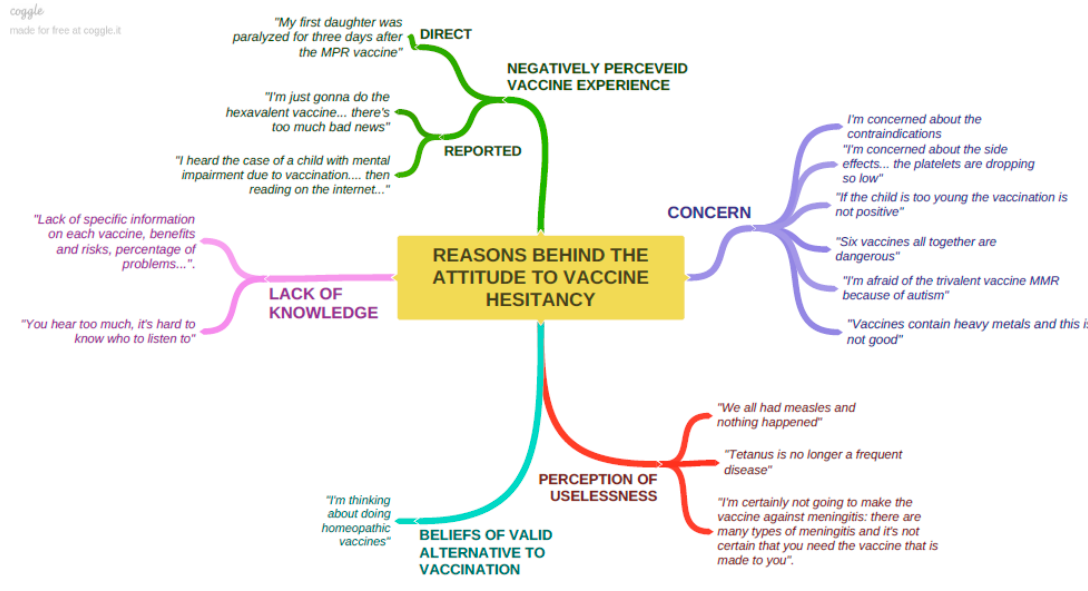
Table 2. Different exposures to communication regarding vaccines: prevalence of mothers in each subgroup.